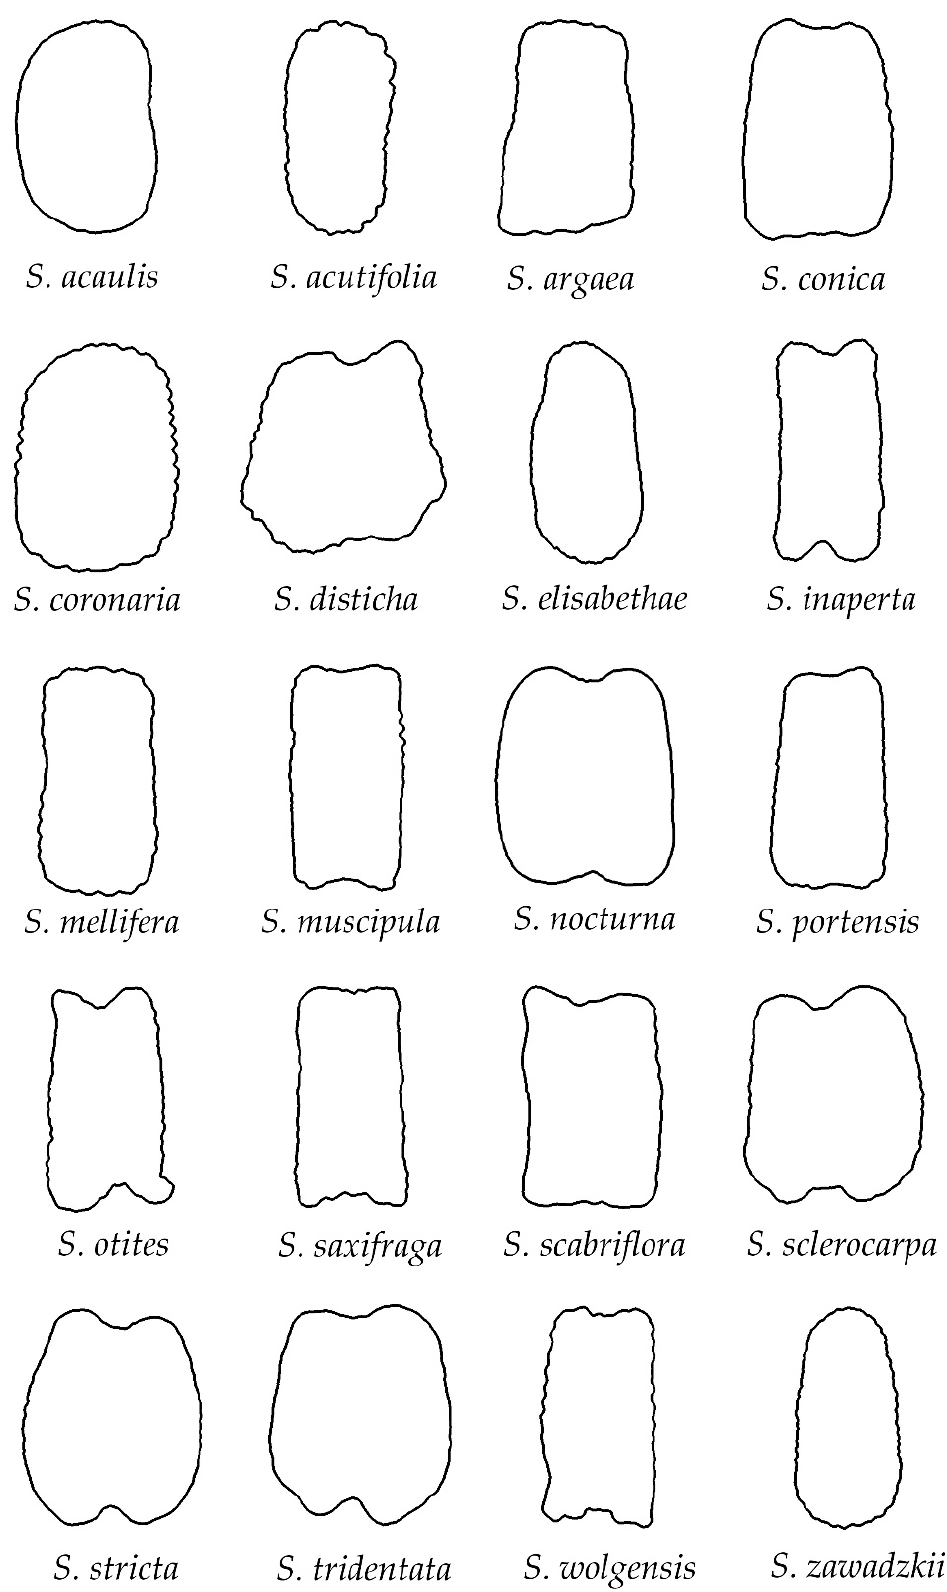
Figure 5. Silhouettes of the dorsal views of Silene seeds belonging to the group of seeds with round tubercles.